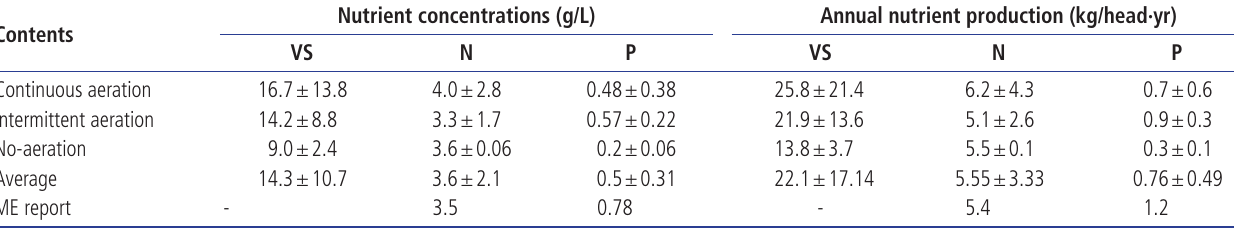
Table 3. Nutrient concentrations in liquid part of swine manure and annual nutrient production